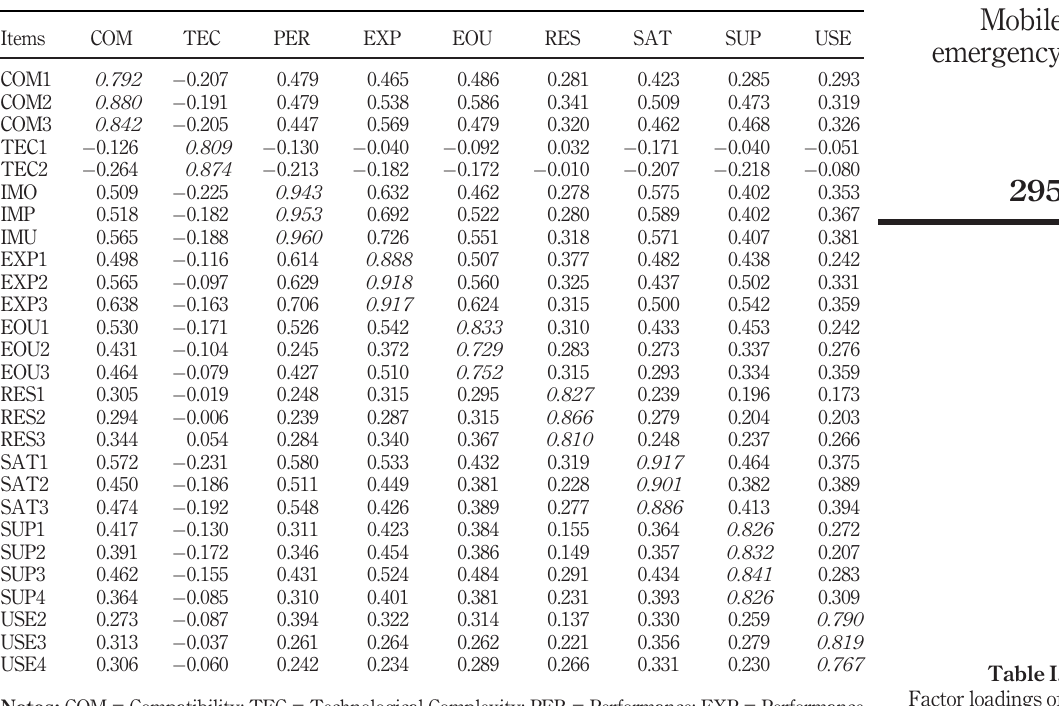
Table I. Factor loadings of